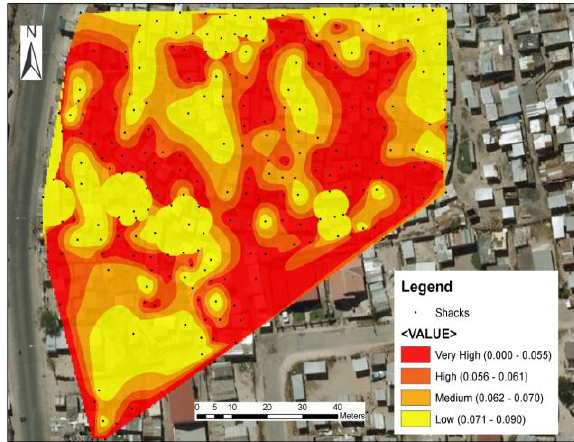
Figure 7. Raster map showing vulnerability based on efficiency of mitigation methods (Musungu 2012: